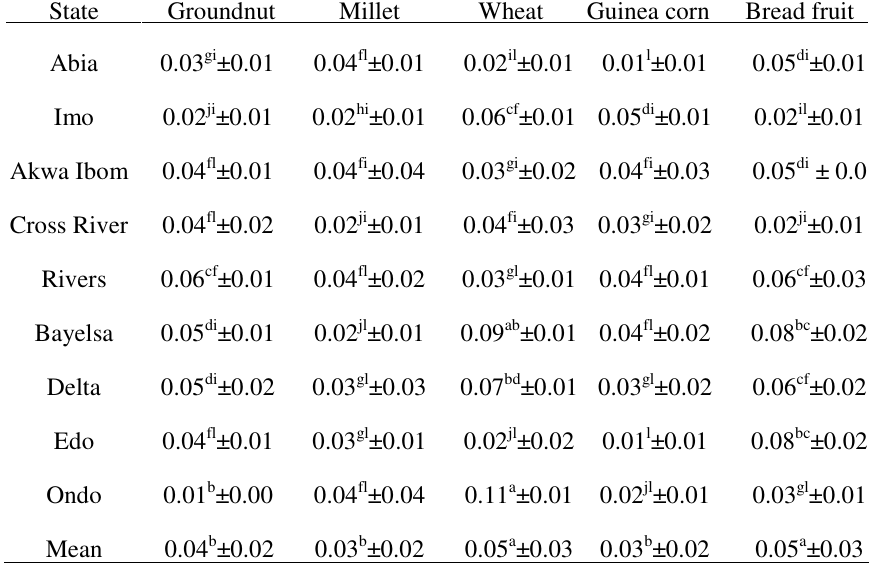
Values are mean ± S.D of three determinations. Values not sharing common superscript letter (s) in a column are significantly different at